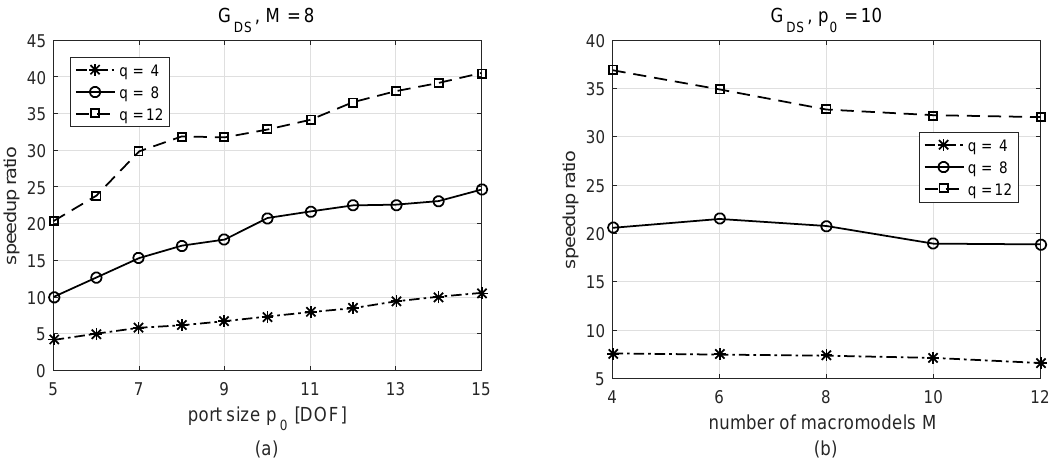
Figure 6. Gain of diagonalization with the Schur solver G DS : versus port size p 0 for M = 8 ( a ); and versus number of macromodels M for p 0 = 10 ( b ).